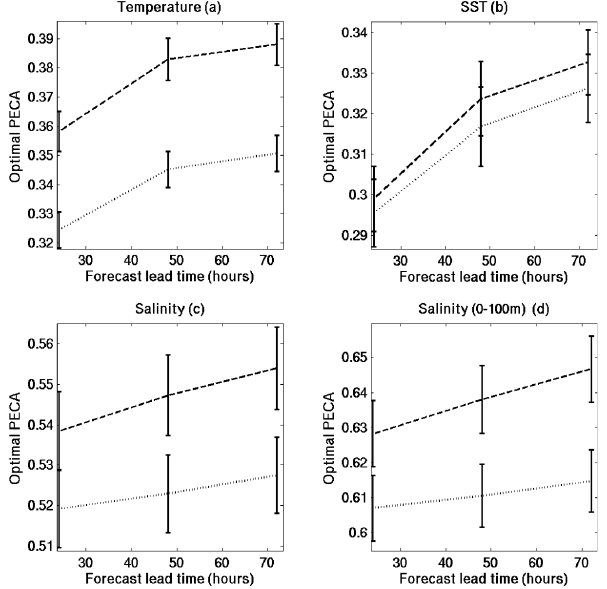
Fig. 4. Optimal PECA as a function of forecast lead time for ensembles r (dotted) and q (dashed) for temperature in full observation space (a) , surface temperature (b) , salinity in full observation space (c) , and salinity in layer between 0 and 100m (d) . Error bars based on the standard error indicate the confidence